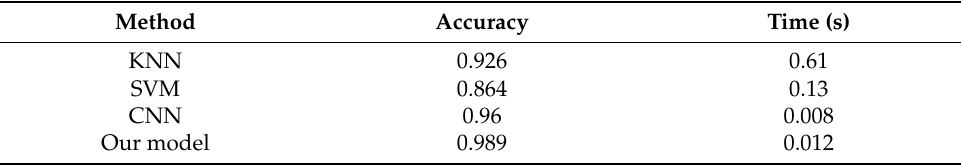
Table 5. Results of accuracy and time for different classification